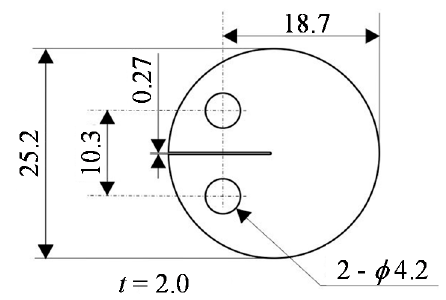
Figure 1. Specimen configuration for fatigue crack propagation tests.